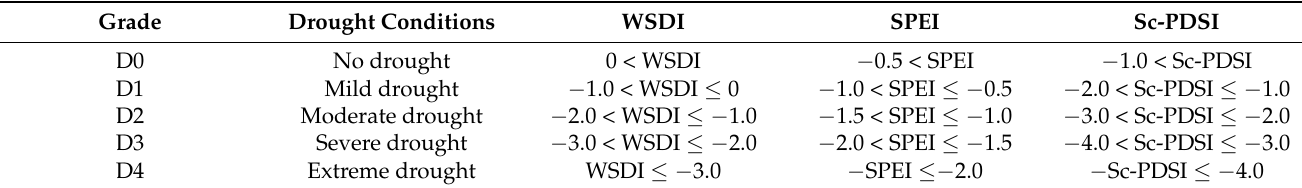
Table 2. The WSDI, SPEI, and sc-PDSI drought